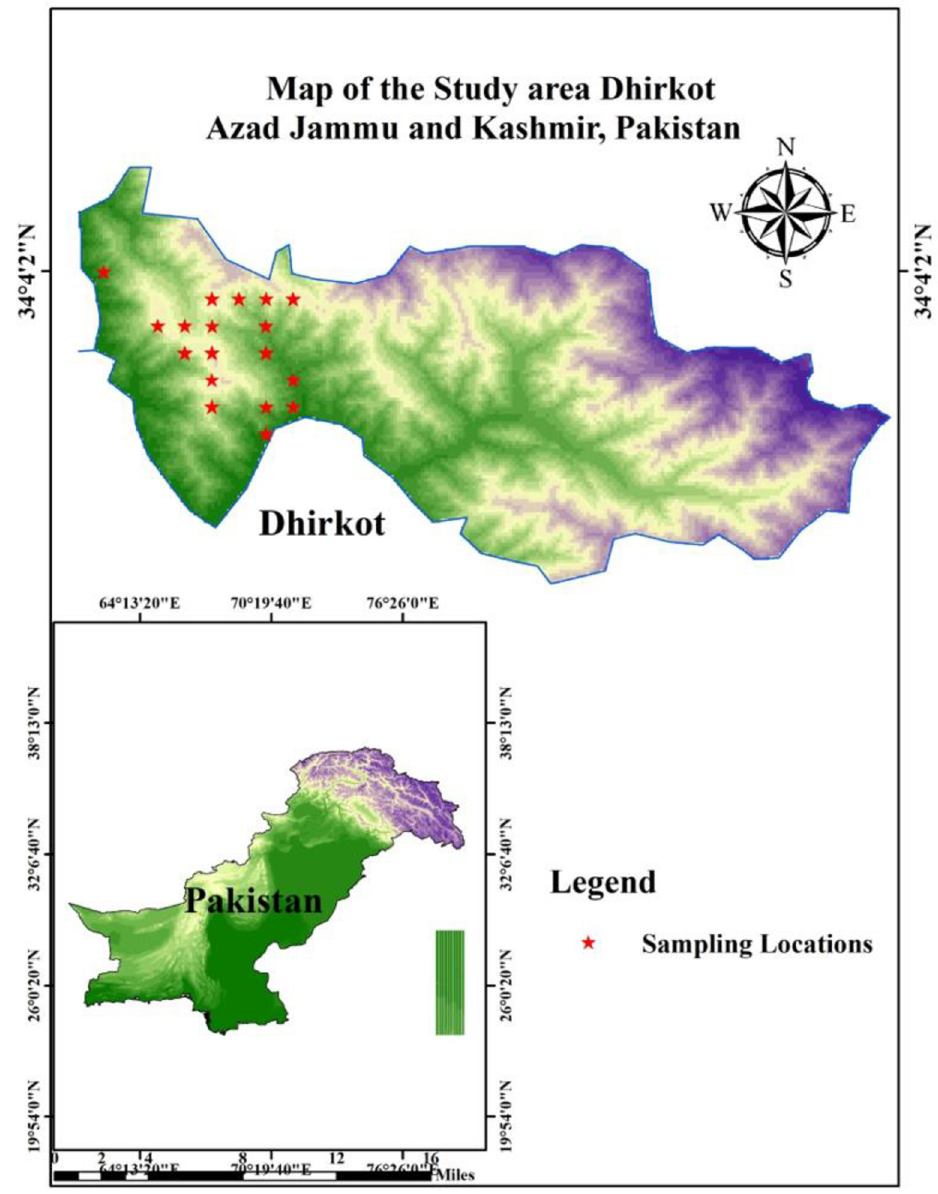
Fig 1. Map of study area Dhirkot Azad Jammu and Kashmir,